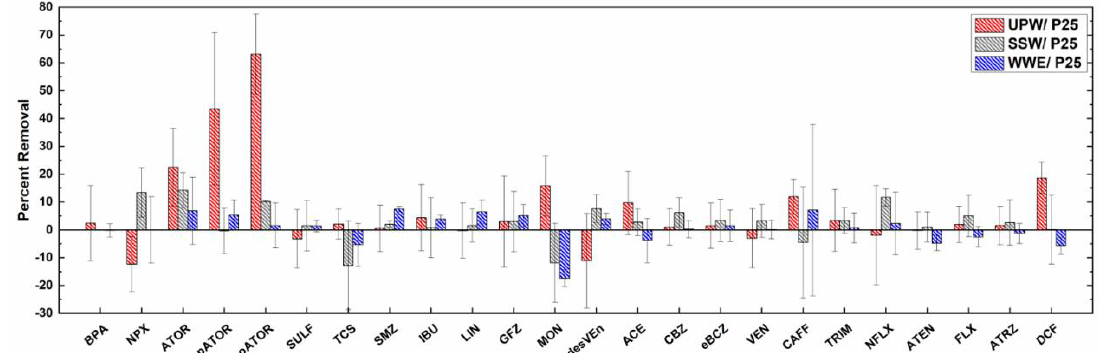
Figure 1. Removal of PPCP in ultrapure water (UPW), synthetic surface water (SSW), and wastewater effluent (WWE) during the equilibration period (60 min in the dark and at room temperature). Negative values are within the 15% acceptable experimental error.